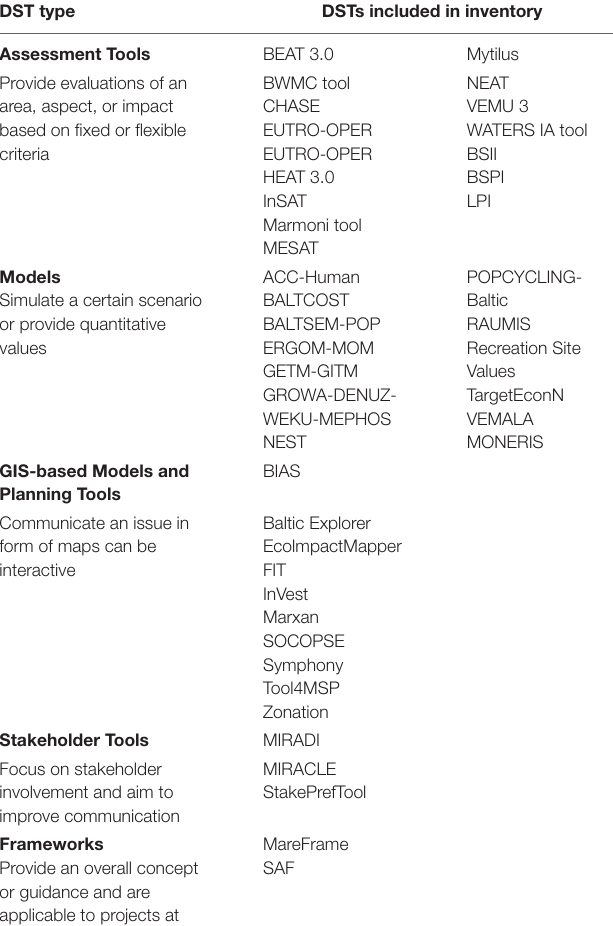
TABLE 1 | Overview of available decision support tool (DST) types and specific DSTs resulting from the stocktaking. DST